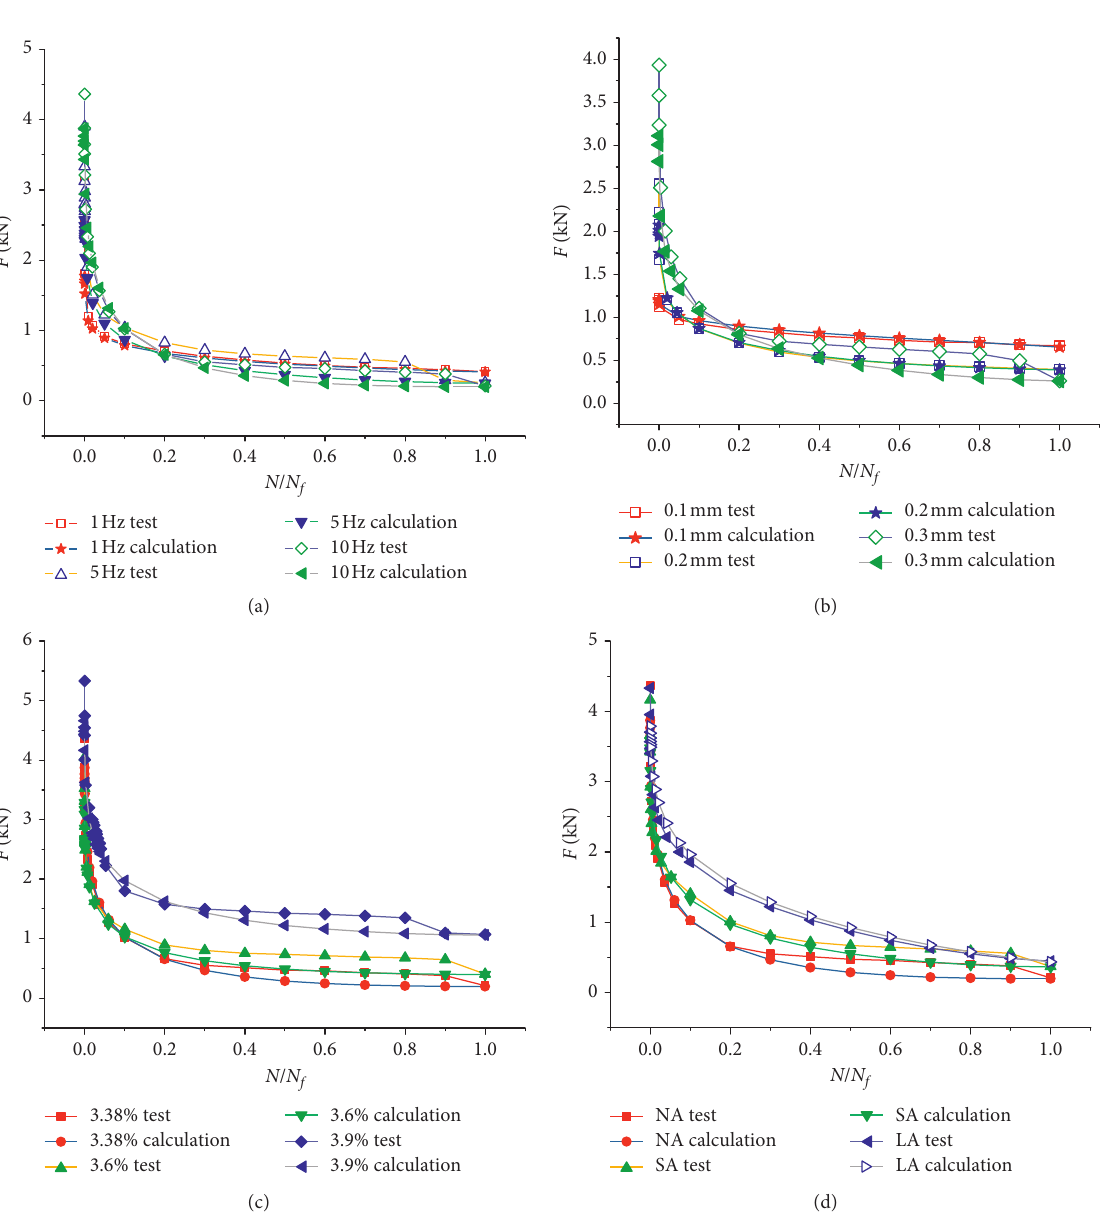
Figure 7: Test and theoretical curves corresponding to the (a) frequency, (b) loading displacement, (c) asphalt-aggregate ratio, and (d) aging